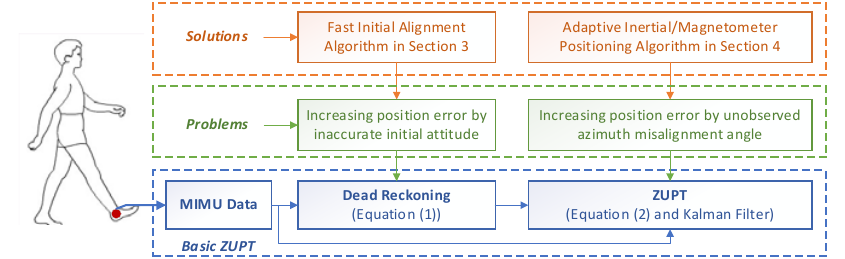
Figure 1 . The relationships between basic ZUPT, its problems and the proposed algorithms. Figure 1. The relationships between basic ZUPT, its problems and the proposed